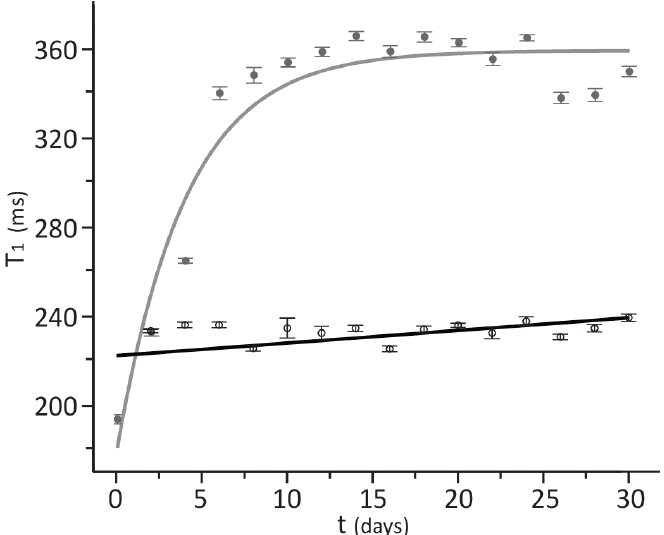
Figure 3. Comparison of sterile (open circles) to unsterile (solid circles) T function of room temperature exposure time. The 95% confidence intervals corresponding to averaging over 15 samples are included in the